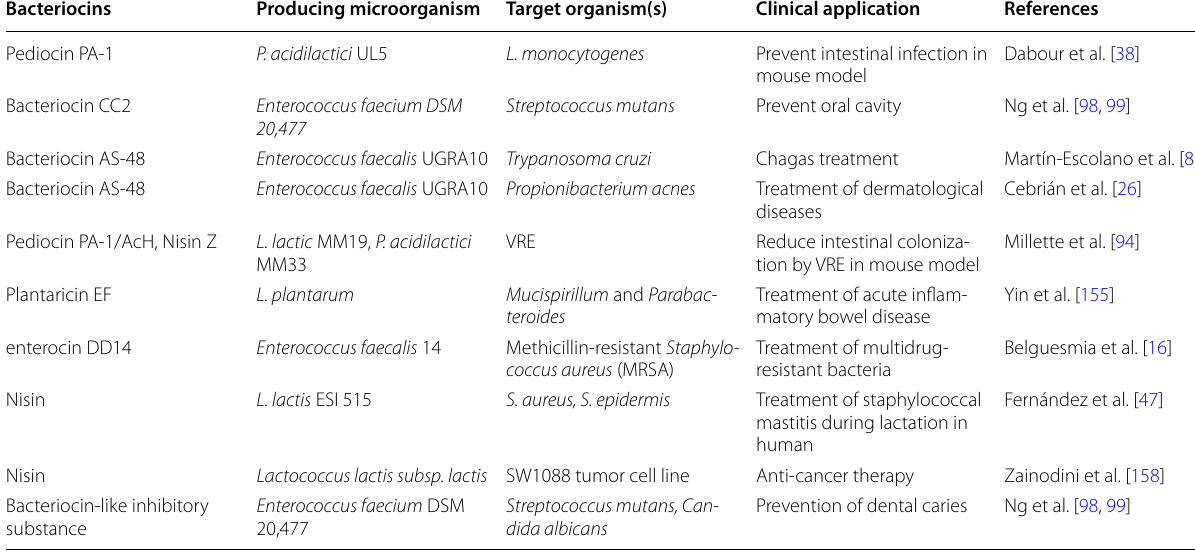
Table 5 Examples of the bacteriocin in the clinical applications